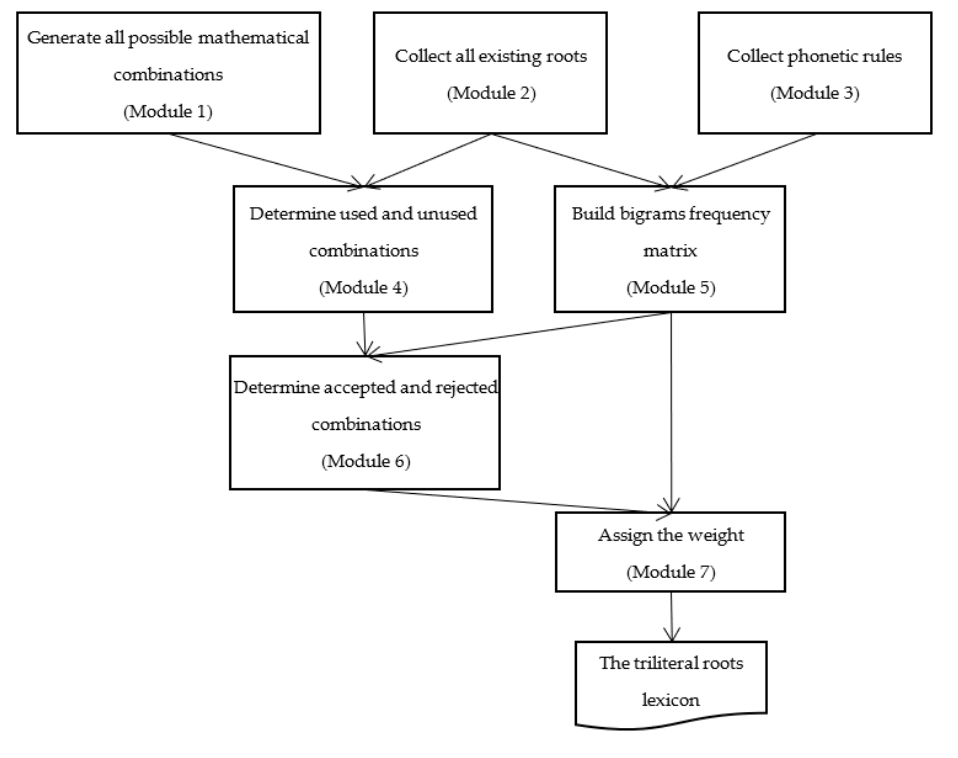
Figure 1. Proposed Approach.